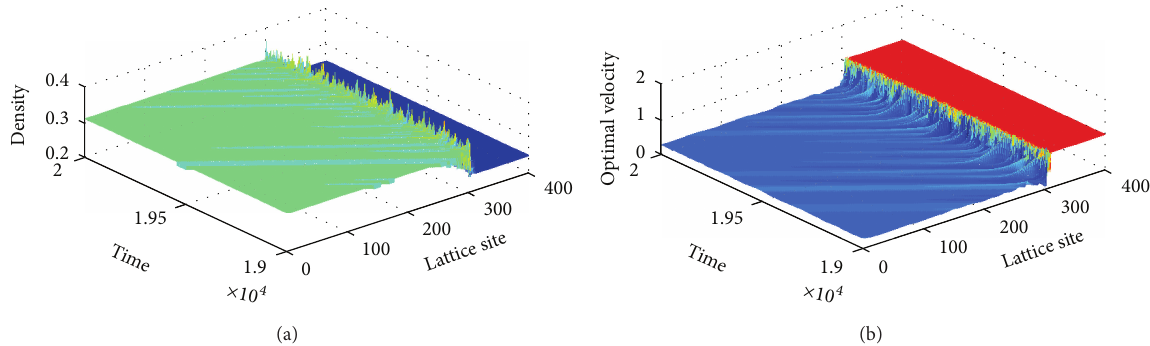
Figure 9: The spatiotemporal evolutions of HCT for 𝜌 ℎ = 0.25 , 𝑄 on = 0.18 .